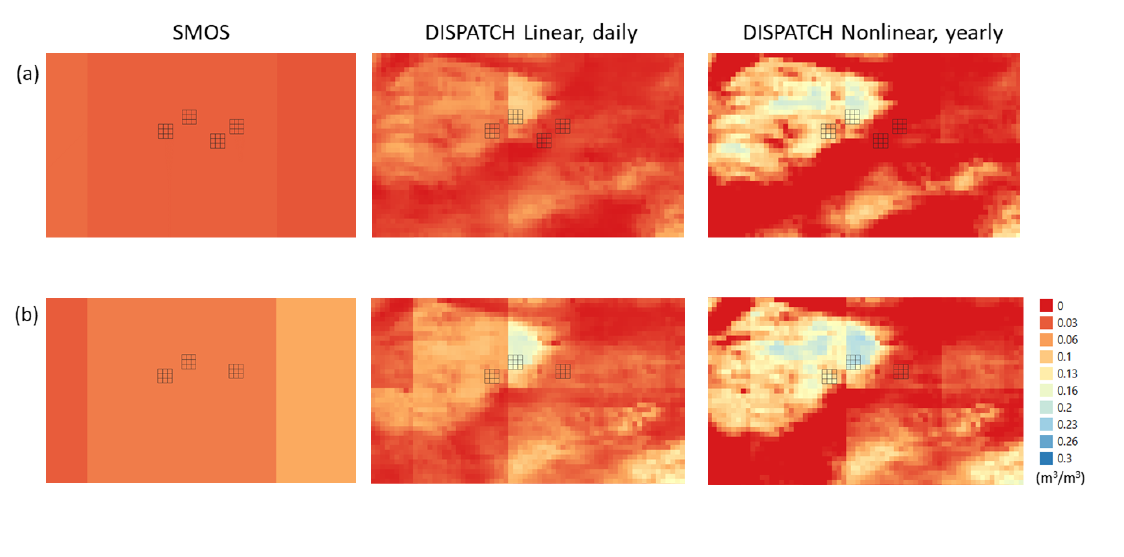
Figure 3. The SMOS and DISPATCH SM on DOY 196 (year 2011)—( a ) and DOY 223 (year 2015)—( b ). DISPATCH SM is obtained using the linear SEE(SM) model with a daily calibration and the nonlinear SEE(SM) model with a yearly calibration. The 1 × 1 km pixels within the sampling areas are also shown (four 3 by 3 km sites for 2011 and three for